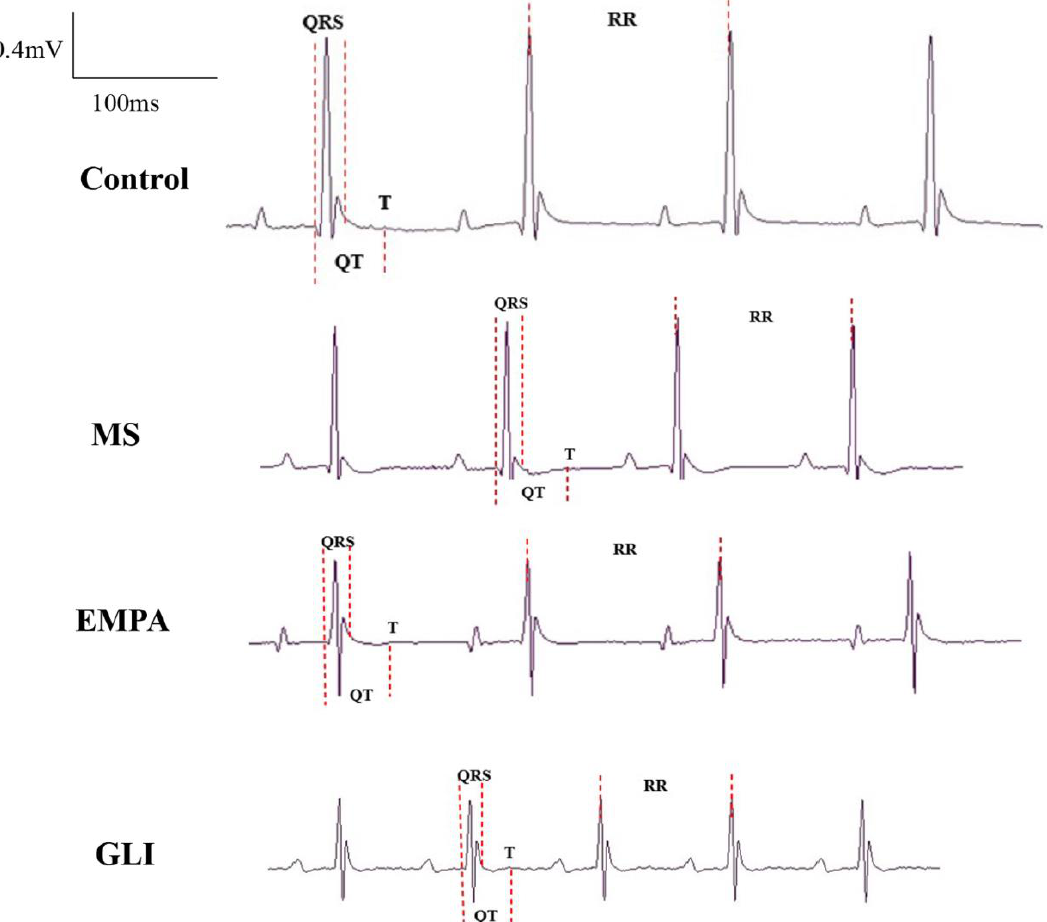
Figure 2. An example of measuring characteristics of electrocardiography (ECG) in the ventricles among the study groups ( n = 5 for each group). The dashed lines indicate measurements of the QRS wave duration, RR interval, and QT interval.